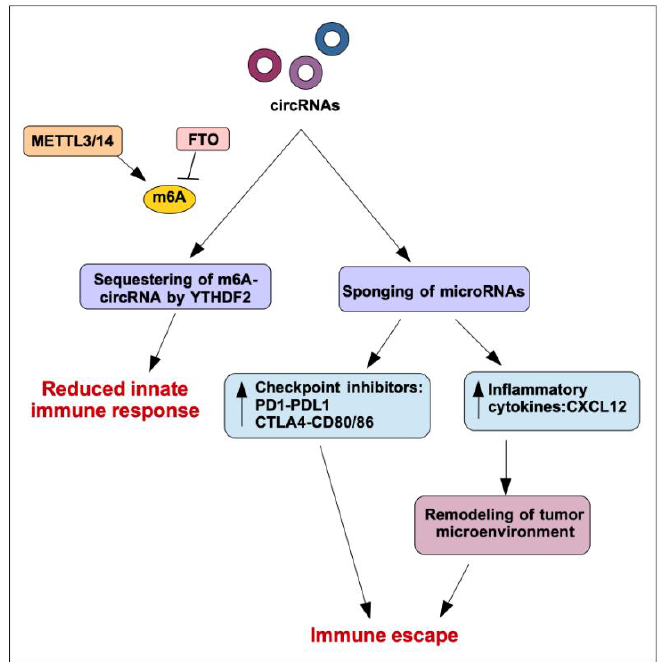
Figure 3. Impact of circRNAs on translatiuon and immune functions. The N6-methyladenosine (m6A) RNA modification of human circRNA, promoted by the activity of METTL3/14 while counteracted by FTO, leads to the inhibition of the innate immune response, which is based on the subtraction of modified circRNAs by the reader m6A YTHDF2. In the context of cancer, circRNAs impact immune function due to their miRNA sponging activity. In fact, the inhibition of microRNAs leads on the one hand to the induction of checkpoint inhibitors and, on the other, to the released expression of soluble inflammatory mediators, such as CXCL12. Both of these activities promote the depletion of T lymphocytes and immune escape.